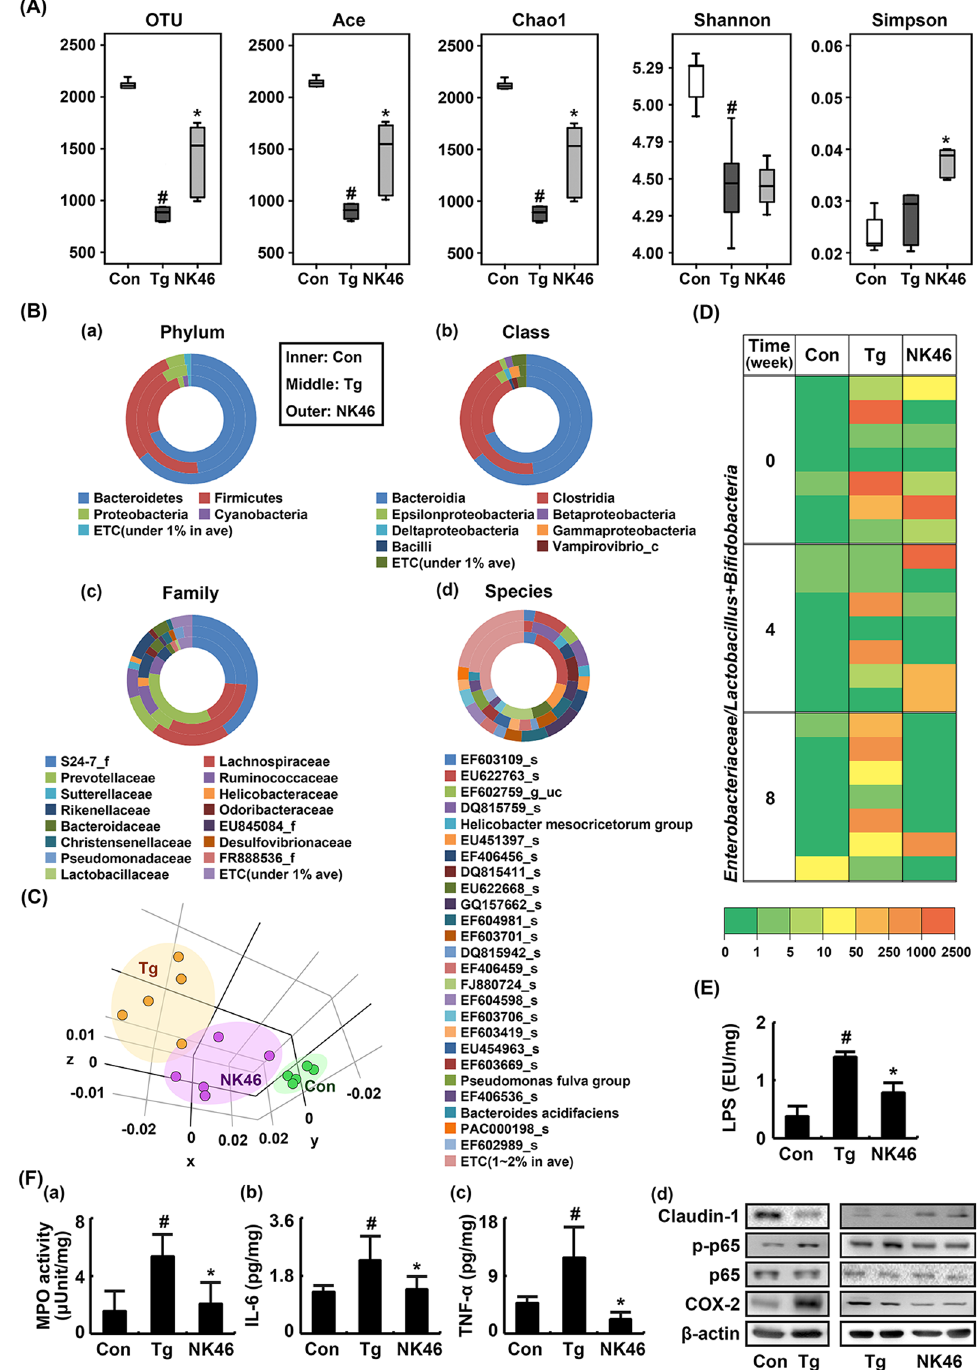
Figure 2. NK46 modified the gut microbiota composition in 5XFAD Tg mice. ( A ) Effect on the number of sequences analyzed, operational taxonomic units (OTUs), abundance-based coverage estimator (ACE), Chao1, Shannon, and Simpson. ( B ) Effect on the fecal microbiota composition: phylum (a), class (b), family (c), and species (d). ( C ) Principal coordinate analysis (PCoA) plot. The plot shows the clustering pattern among control (Con), vehicle- (Tg), and NK46-treated Tg mice (NK46) based on weighted pairwise Fast UniFrac analysis (n = 5). ( D ) Effect on the ratio of Enterobacteriaceae populations to Bifidobacteria plus Lactobacilli populations, assessed by the selective media (n = 6). ( E ) Effect on the fecal LPS levels. ( F ) Effect on the myeloperoxidase (MPO) activity (a) and IL-6 (b), TNF- α (c), claudin-1, and COX-2 expression, and NF- κ B activation (d) in the colon. IL-6 and TNF- α levels were measured using ELISA and COX-2, claudin-1, p65, p-p65 were using immunoblotting. Test agent (Tg, vehicle alone; NK46, 1 × 10 9 CFU/mouse/day) was orally administered for 2 months in Tg mice. Control mice (Con) were treated with vehicle alone. All data were expressed as mean ± SD (n = 6). # p < 0.05 vs. Con group. * p < 0.05 vs. Tg